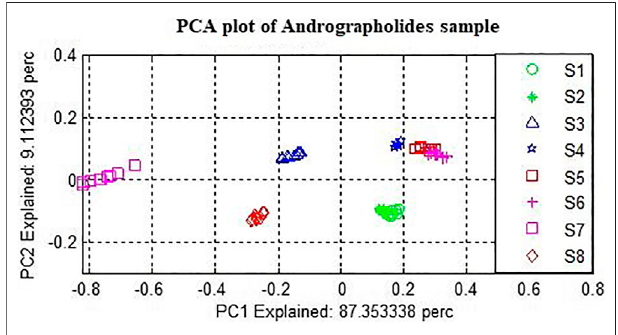
FIGURE 6 | PCA plot with fi rst two PC.